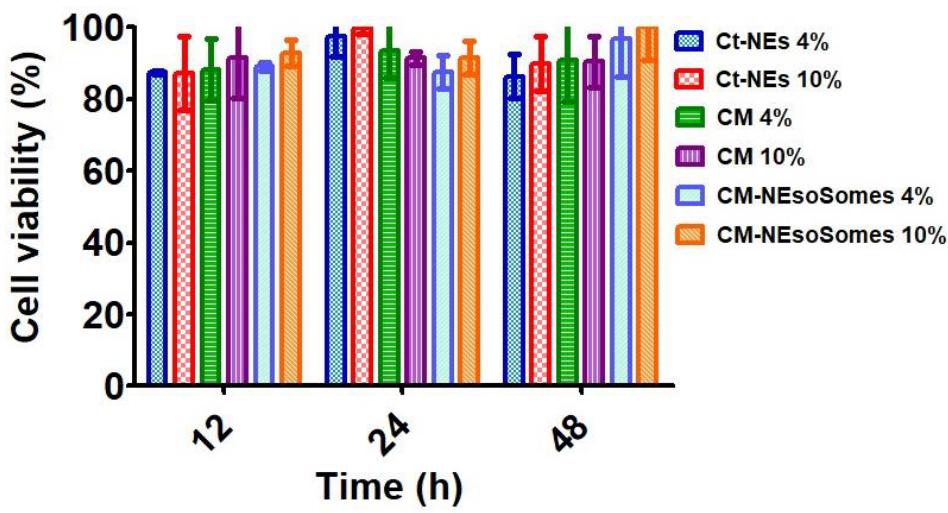
Figure 4. Cell Viability Assessment obtained by Alamar Blue Assay.